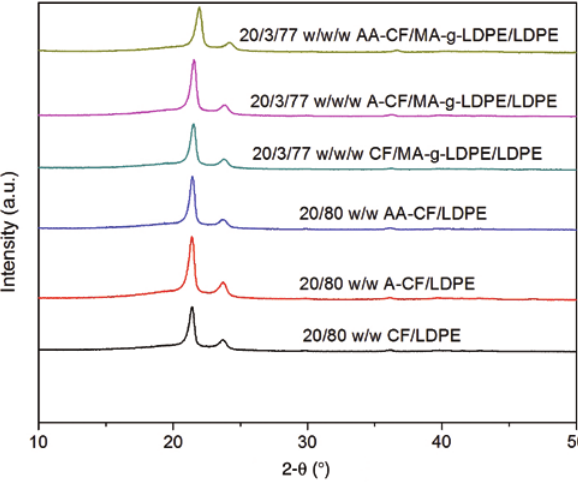
Figure 9: X-ray diffractograms of CF/LDPE composites.